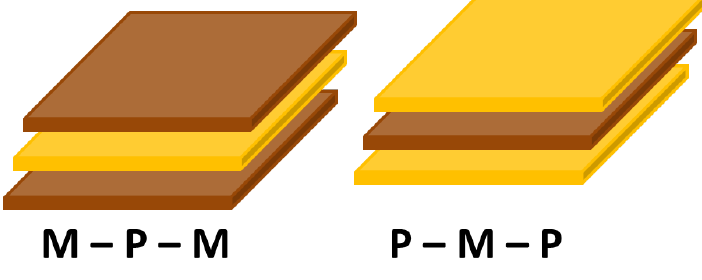
Figure 19. Schematic diagram of ME trilayer composites with two-type